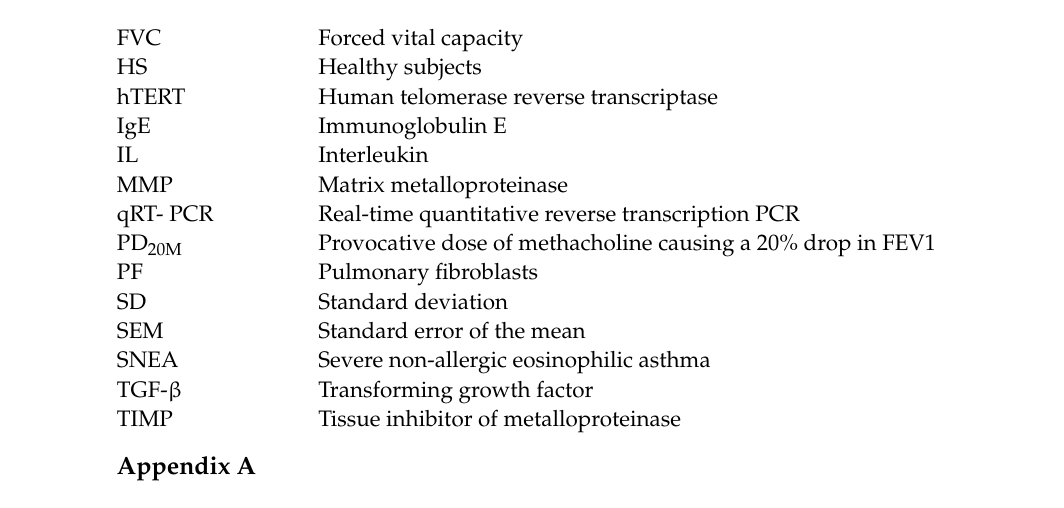
Smooth muscle cells, fibroblasts,